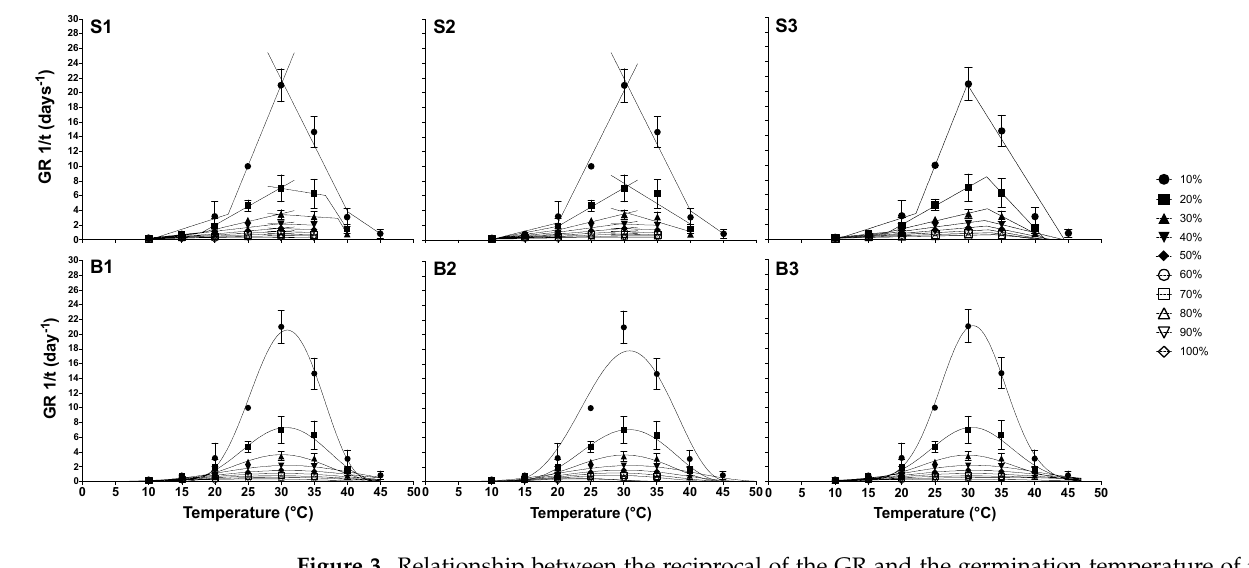
Figure 3. Relationship between the reciprocal of the GR and the germination temperature of the percentiles in the cardinal temperature range. Symbols represent experimental data, while the solid lines correspond to the predicted values by segmented (S1–S3) and beta functions (B1–B3). Table 3. Estimated parameters for segmented model (S1) of Salvia hispanica seeds. Root mean square of deviations (RMSE) and coefficient of determination (R 2 ) for the relationship between emergence rates.